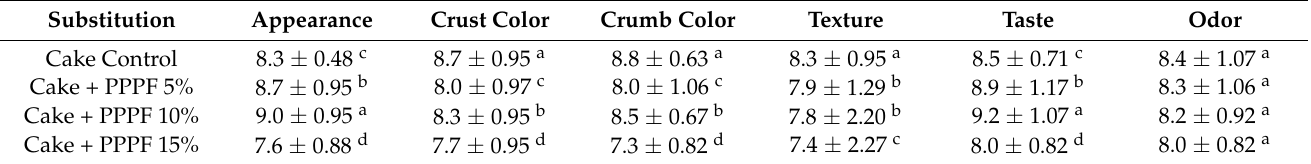
Table 9. Sensory analysis of cakes prepared by replacing flour with various levels of prickly pear peel flour